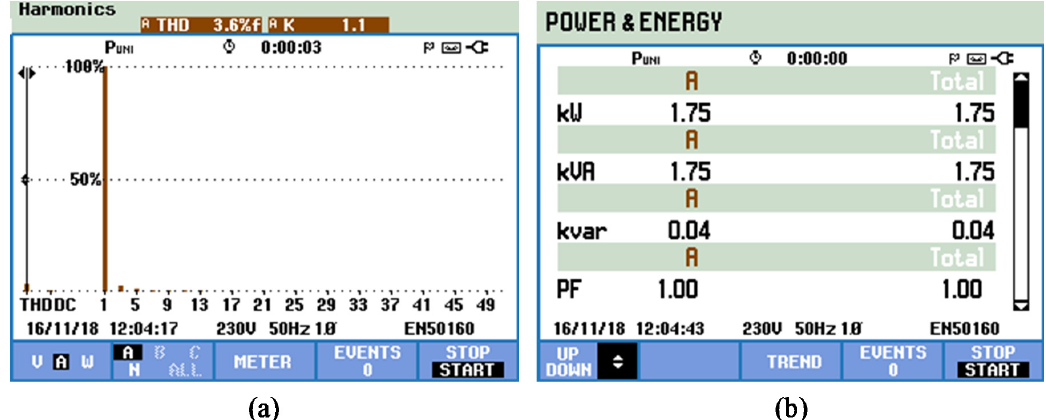
Figure 9. Experimental results during the MF-EVCS operation in G2V mode combined with the operation as APF: ( a ) Harmonic spectrum of the total home current ( i g ); ( b ) Operating powers and total power factor.